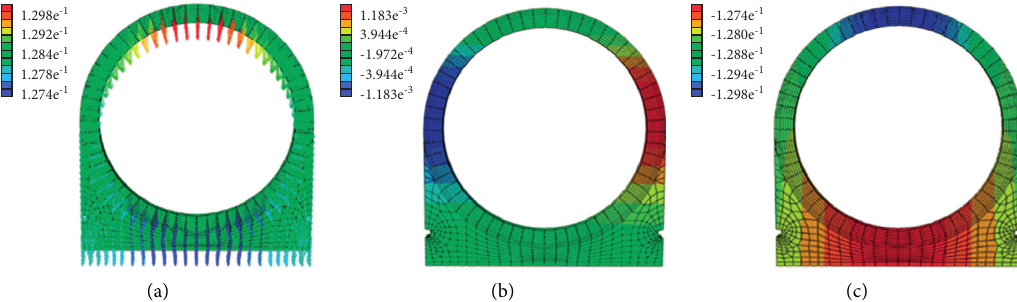
Figure 14: Incremental deformation of prestressed culvert structure: (a) deformation vector diagram; (b) horizontal deformation; (c) vertical deformation.